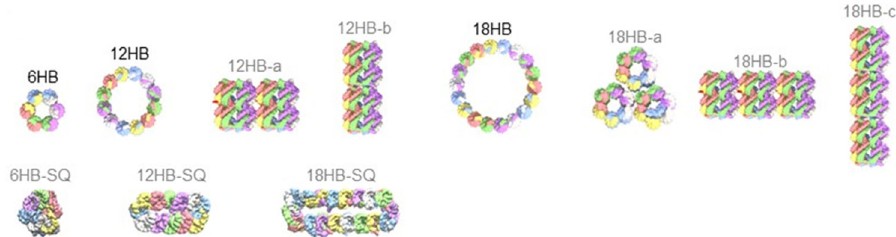
Fig. 4 Representative models for the 6HB, 12HB, and 18HB structures used for calculating CCS values reported in Table 1. Multiple 6HB barrels are either placed side-by-side (12HB-a, 18HB-a, and 18HB-b) or stacked end- to- end (12HB-b and 18HB-c). The larger-diameter barrels 12HB and 18HB, next